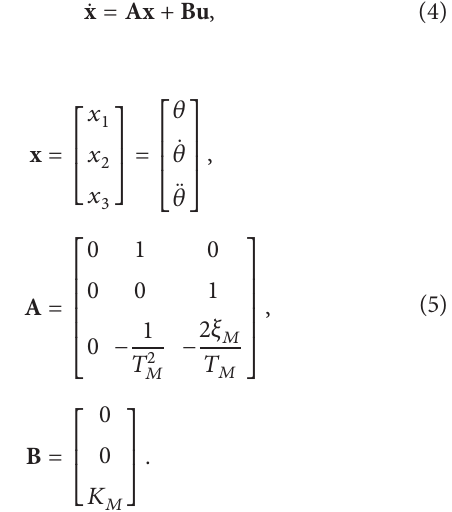
Figure 1: Schematic of impulsive control